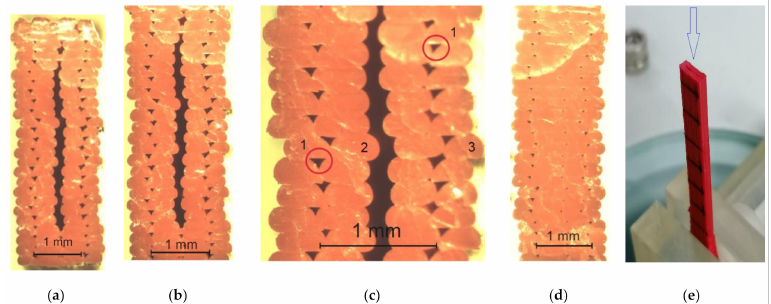
Figure 12. Cross-sectional views of the PLA specimens examined with a stereo microscope; ( a ) a 1.8 mm thick specimen, × 6 magnification, ( b ) a 1.8 mm thick specimen, × 12 magnification, ( c ) a 1.8 mm thick specimen, × 25 magnification, (1—voids at the interface between the neighboring layers, 2—a layer displaced inwards, 3—a layer displaced outwards), ( d ) a 1.4 mm thick specimen, × 12 magnification, ( e ) top view of samples during microscopy measurement.